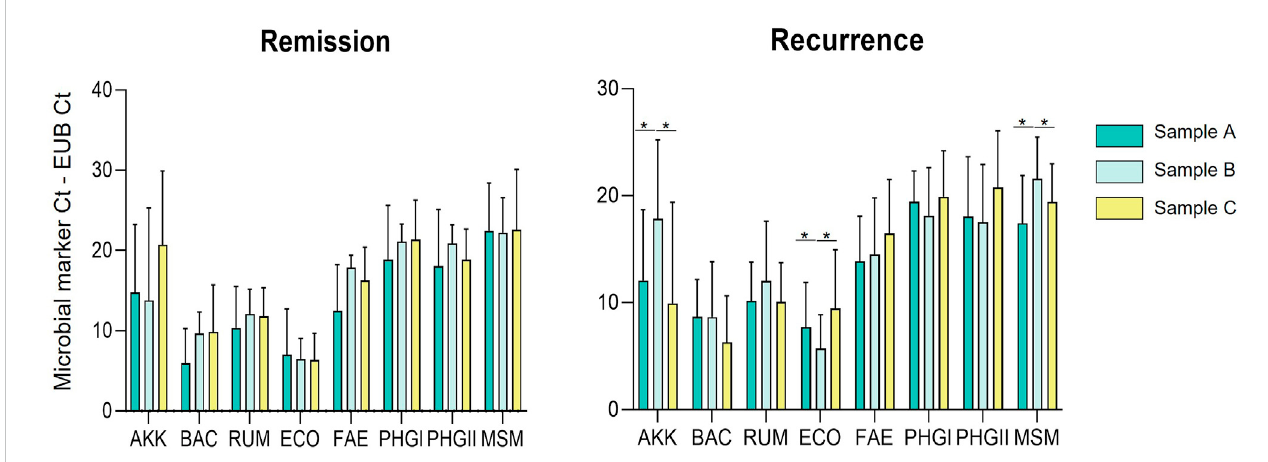
FIGURE 2 Plot of the relative abundances (Microbial marker Ct — Eubacteria Ct) of A. muciniphila (AKK), Bacteroidetes (BAC), Ruminococcus spp. (RUM), E. coli (ECO), F. prausnitzii (FAE), F. prausnitzii phylogroup I (PHGI), F. prausnitzii phylogroup II (PHGII), M. smithii (MSM) for sample A (before surgery), sample B